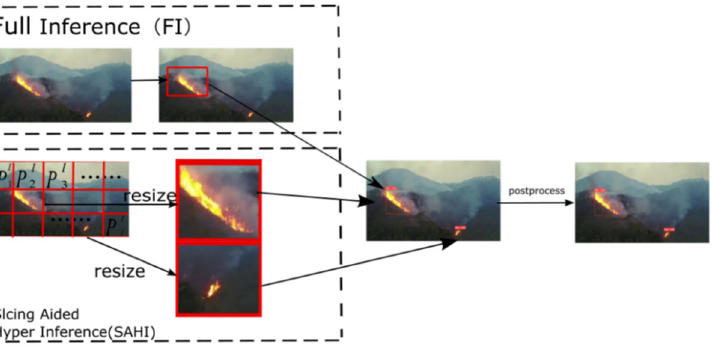
Figure 9. The reasoning process diagram of the Slicing Aided Hyper Inference framework for forest fire pictures.